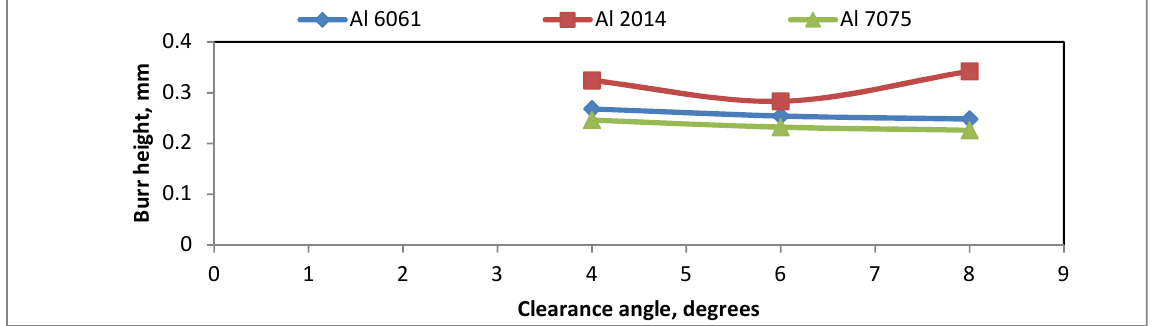
Fig. 11. Effect of increasing the clearance angle on burr height (SET-1)